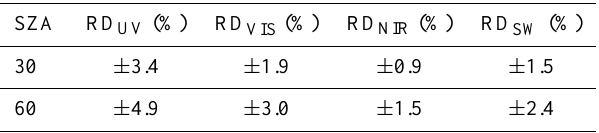
Table A1. Mean relative difference (RD) in the UV, VIS, NIR, and SW net fluxes if SSA = 0.90 and g = 0 . 75 are compared with dif- ferent SSA and g scenarios for different SZA values.